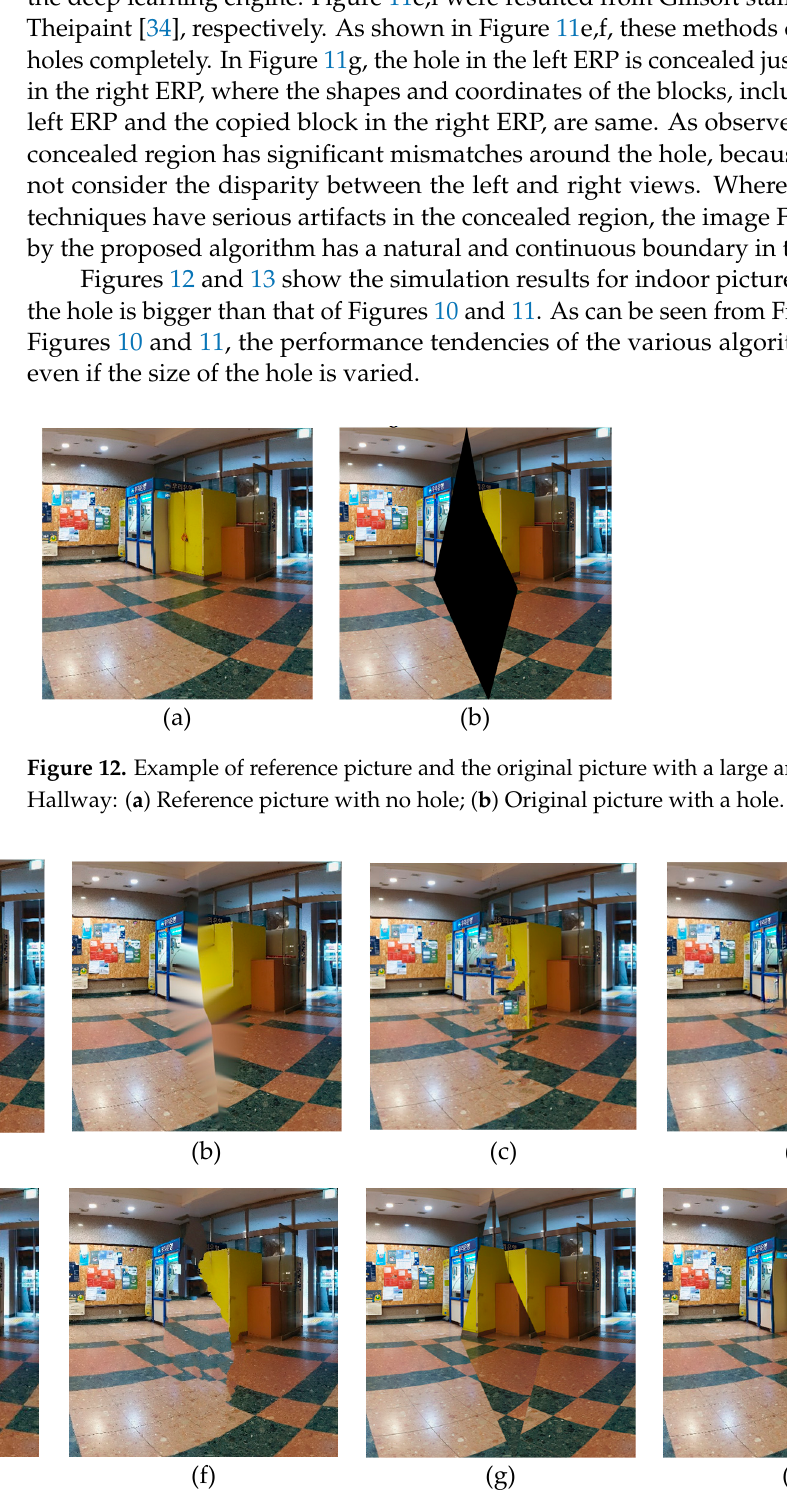
Figure 13. Concealed images resulting from various algorithms for a large hole for test set Hallway: ( a ) Result from Bertalmio [16]; ( b ) Result from Telea [17]; ( c ) Result from Criminisi [18]; ( d ) Result from Liu [19]; ( e ) Result from Gilisoft stamp remover [33]; ( f ) Result from Theinpaint [34]; ( g ) Result from simple copy; ( h ) Result from proposed method.